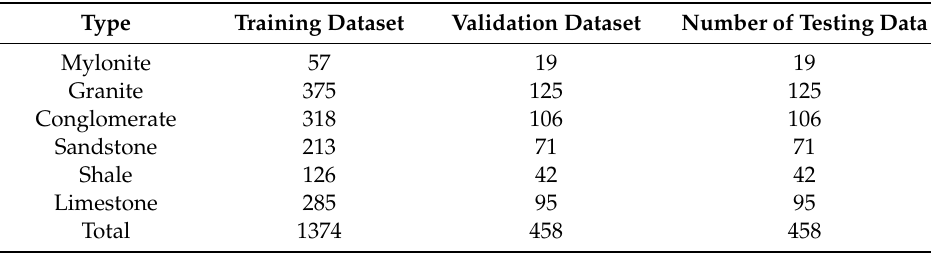
Table 2. Numbers of original field rock